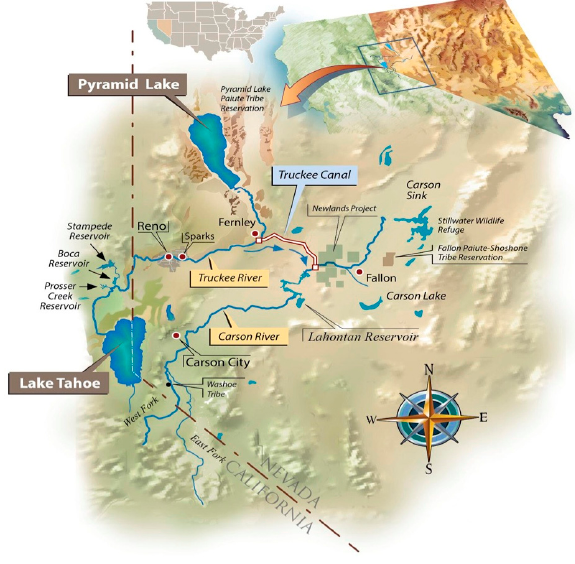
Figure 1. The Truckee-Carson River System [51].